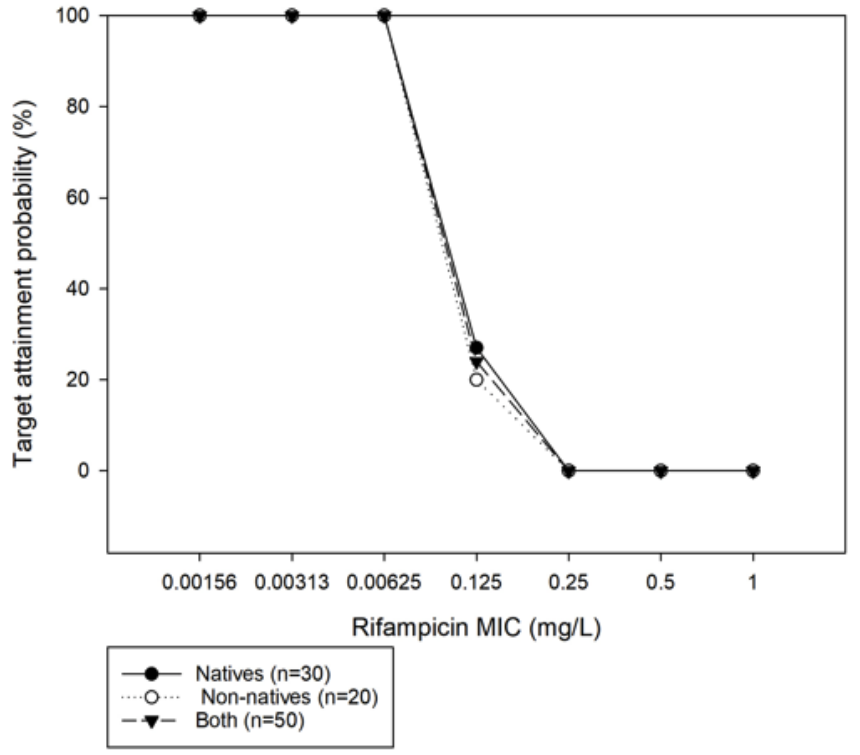
Figure 1. Probability of target attainment (AUC 0–24 /MIC > 271) vs. minimum inhibitory concentration (MIC) in patients at assumed rifampicin MIC (ranged from 0.00156 to 1 mg/L).